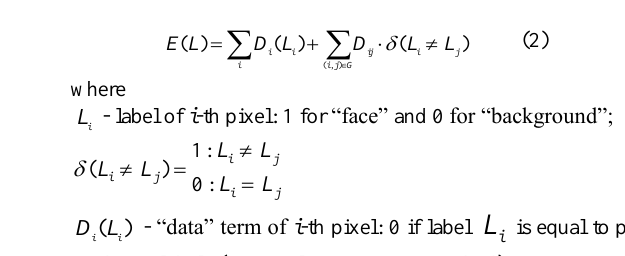
Figure 1. Detection of most stable facial feature points